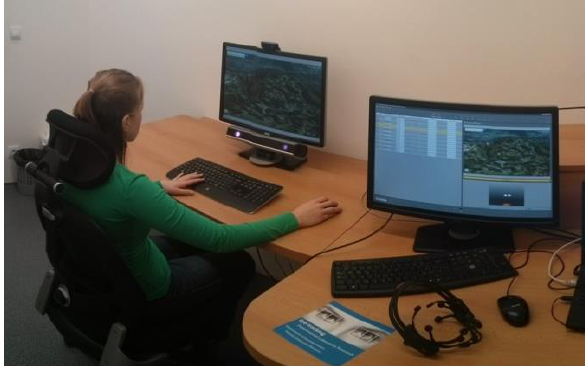
Figure 1. Controlled eye-tracking laboratory.